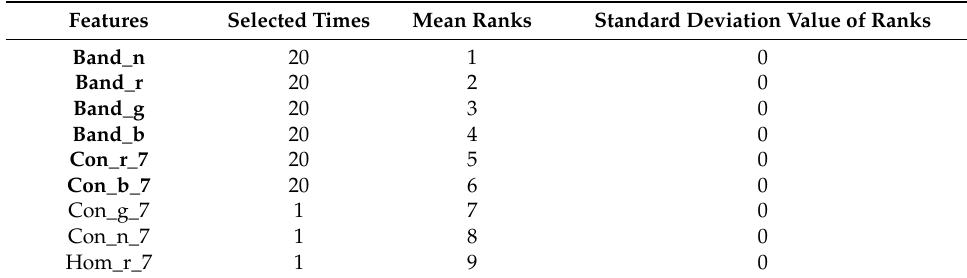
Table 6. Feature selection result for spectral bands adding the texture measures. Band: the spectral band. _b/g/r/n_7: the texture features derived from the blue, green, red, and near-infrared bands using the kernel size 7 × 7 pixels. Con: contrast texture. Hom: homogeneity texture. The bold features were selected as members of the final feature